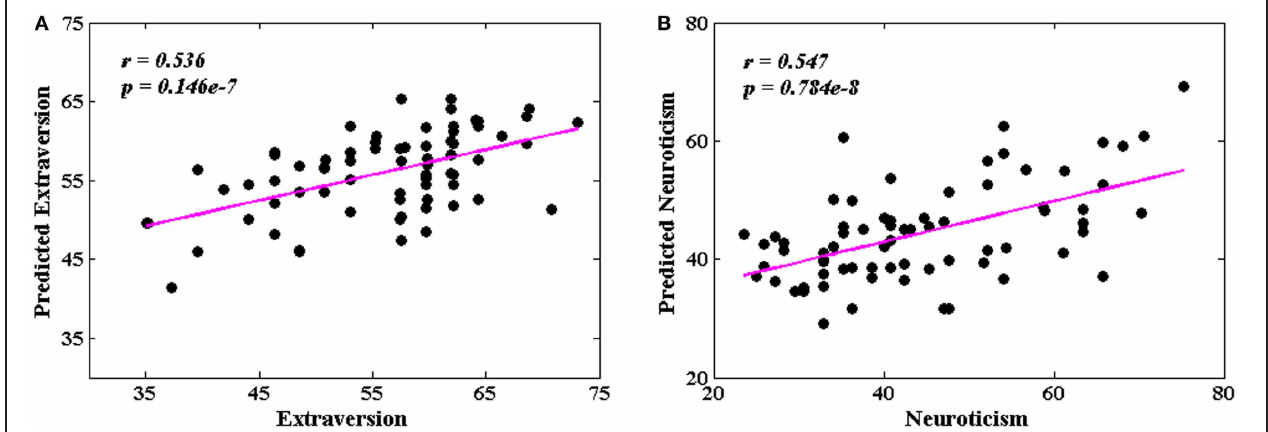
FIGURE 6 | The correlations between the predicted and original personality scores. (A) Extraversion scores ( r = 0 . 536, p = 0 . 146 × 10 − 7 ); (B) neuroticism scores ( r = 0 . 547, p = 0 . 784 × 10 − 8